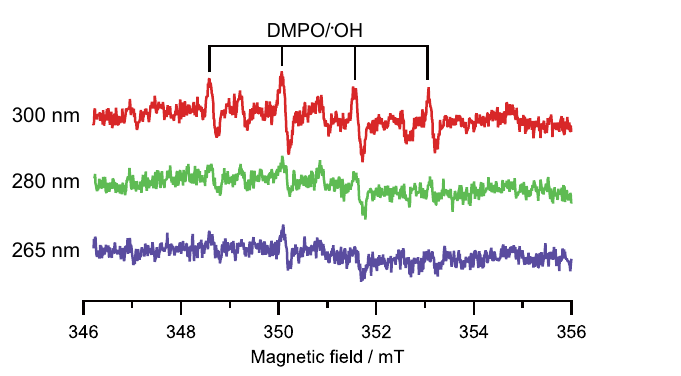
Figure 5. ESR spectra of culture media after DUV-LED irradiation. DMPO was used as the trapping agent of radical species. Details of this assay procedure are described in the Methods